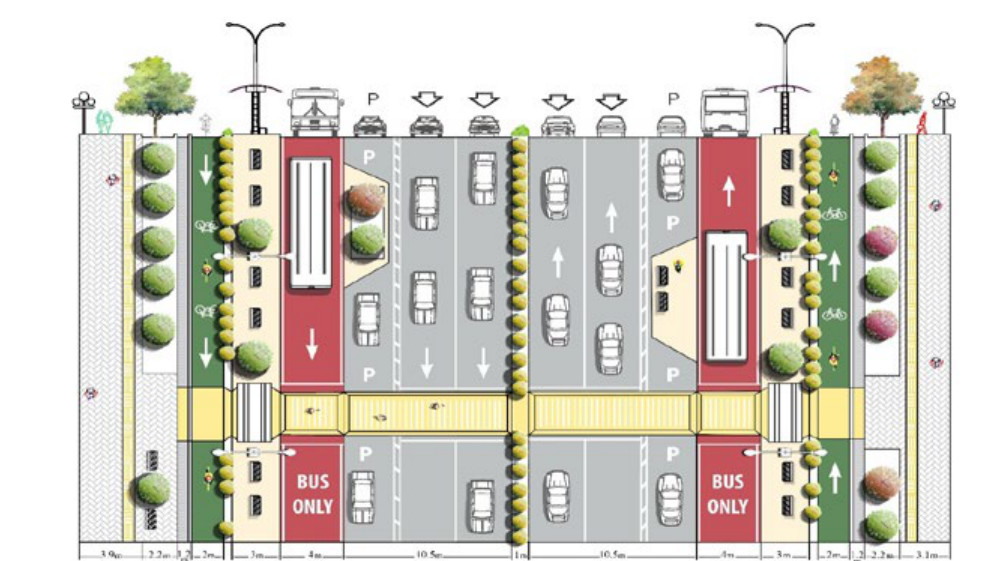
Fig. 10. Designed plan and cross section of Jomhuri